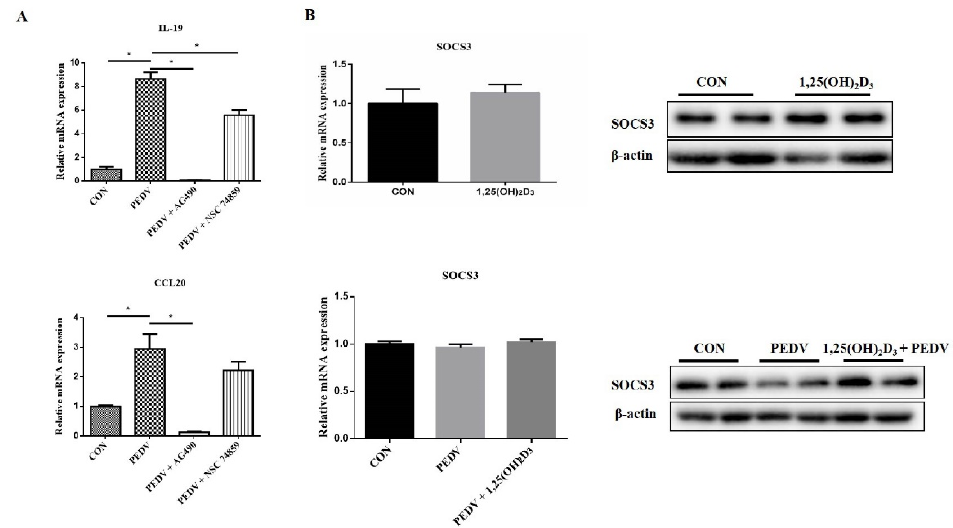
Figure 6. Effects of 1,25(OH) 2 D 3 on SOCS3 expression in PEDV-infected IPEC-J2 cells. IPEC-J2 cells were infected with PEDV for 1 h, and then the cells were washed with PBS and incubated with JAK inhibitor (AG490, 100 µ M) or STAT inhibitor (NSC 74859, 10 µ M) for 24 h. After this, the cells were collected for RT-qPCR analysis ( A ). Sub-confluent cells were incubated with 1,25(OH) 2 D 3 (20 nM) for 24 h, and the cells were collected for RT-qPCR and Western blotting analysis or infected with PEDV (1 MOI). After 1 h of absorption, the cells were washed with PBS and then cultured with or without 1,25(OH) 2 D 3 (20 nM) for another 24 h. Finally, the cells were collected for RT-qPCR and Western blotting analysis ( B ). * p < 0.05.